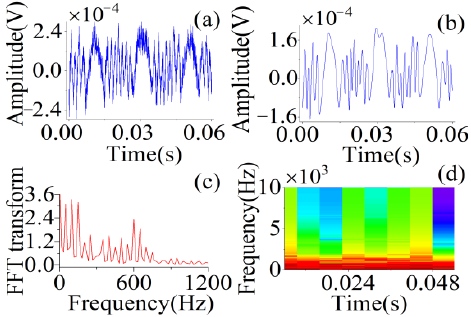
9 of 16 Figure 6. Platform for acquiring SMI microvibration data.